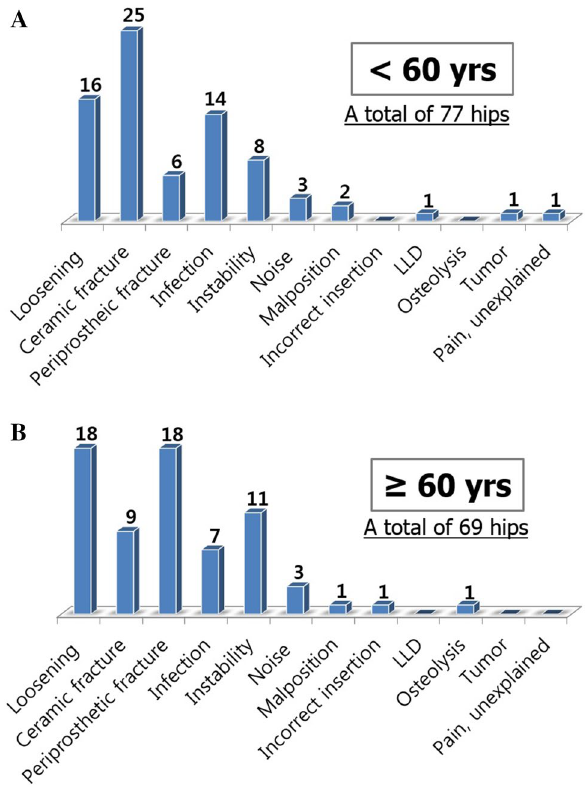
Figure 1. ( A , B ) The reasons for CoC THA revisions according to